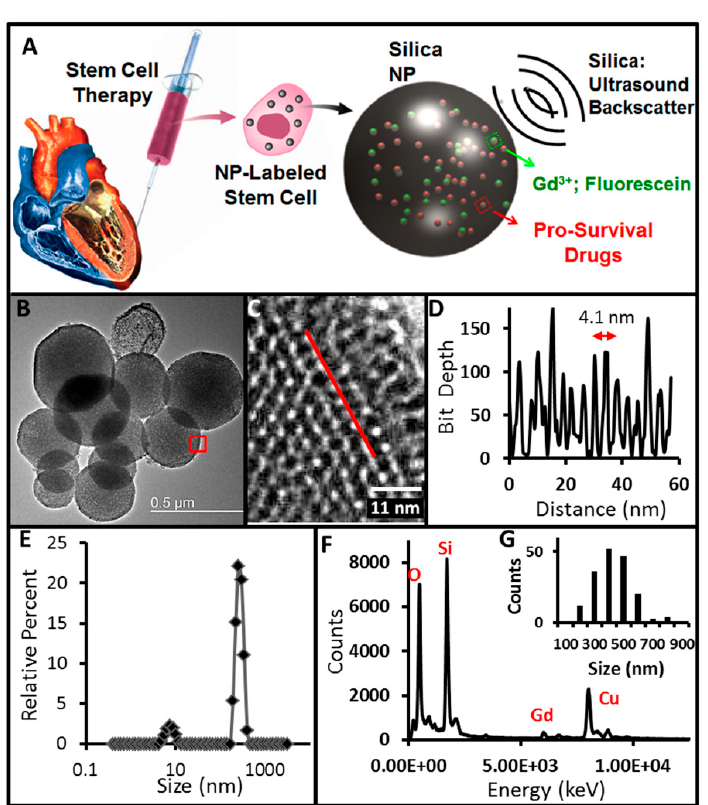
Figure 5. ( A ) MSNs possess impedance disparity to backscatter ultrasound, MRI signal via Gd 3+ , and an optical signal from fluorescein. The same nanoparticles increase MSC survival by ensuring insulin-like growth factor (IGF) sustained release. ( B ) TEM images illustrate mesoporous particles with 4.1 nm pores ( C ) determined by line profiling ( D ). The red box present in ( B ) shows the area imaged at a higher magnification in ( C ). The line in C is representative of the profile used to create ( D ). ( E ) DLS data of the MSNs. Additional characterization by EDS shows projected peaks for silicon and oxygen along with gadolinium from the secondary tag ( F ). The copper signal in (F) is from the TEM grid. Panel ( G ) is a histogram of MSN sizes from the TEM data in nanometer (nm). Reproduced from Reference [91] with permission from the theranostics ivyspring international publisher.